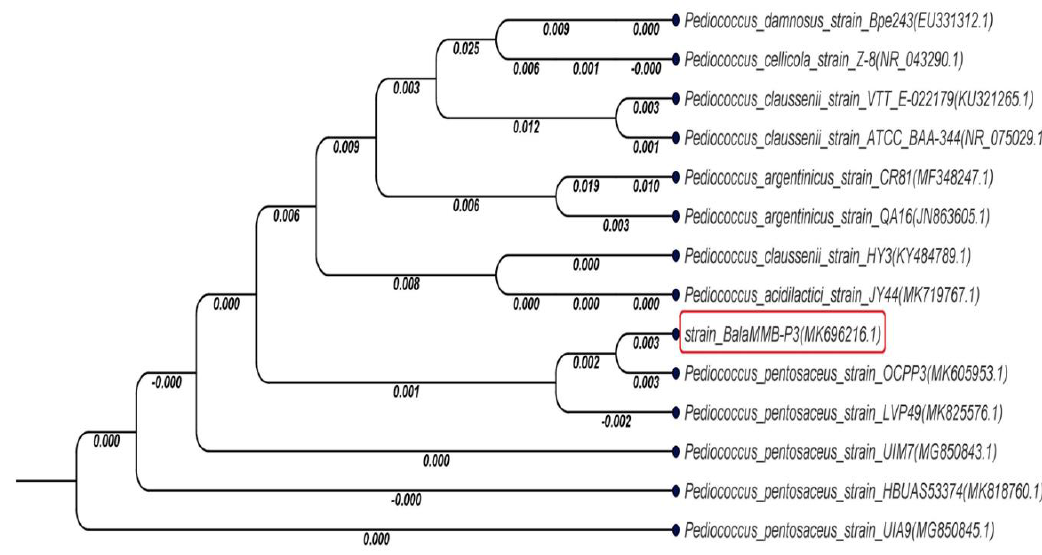
Figure 1. Phylogenetic tree based on 16S rDNA gene sequence showing the relationship between Pediococcus strains and species belonging to the genus Pediococcus. The highlighted red box indicated the species identified in the study.